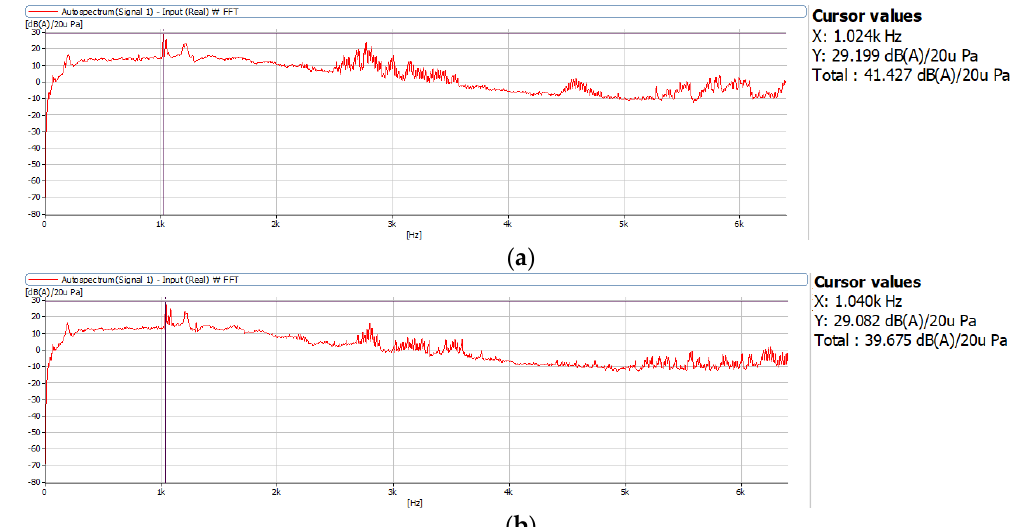
Figure 23. Cogging torque comparison between analysis and measurement results: ( a ) analysis result (base model); ( b ) test result (base model); ( c ) analysis result (proposed model); ( d ) test result (proposed model).